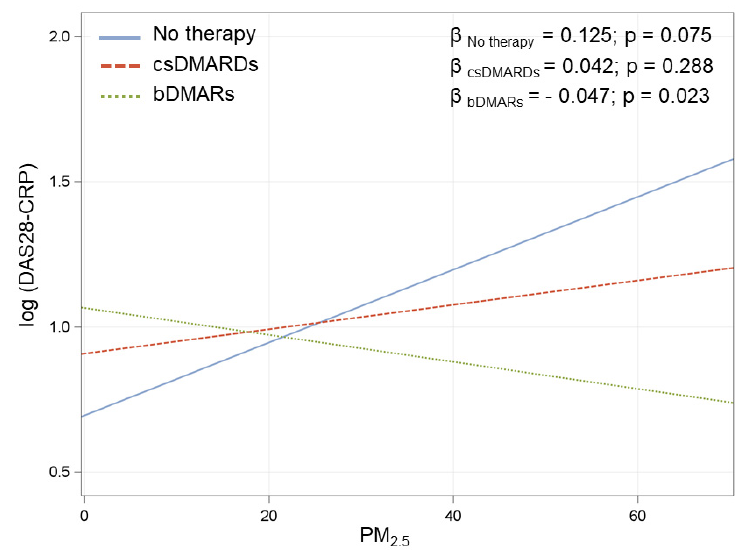
Figure A1. Association between PM 2.5 at day 0 and DAS28 in the three treatment groups. β coeffi- cients are reported for 10 µg/m 3 increments in PM 2.5 . IC: Interval Confidence. Multivariate model adjusted for radiological damage, smoke, seropositivity, treatment (3 categories), corticosteroids, age at visit, disease duration, and interaction between PM 2.5 and treatment.